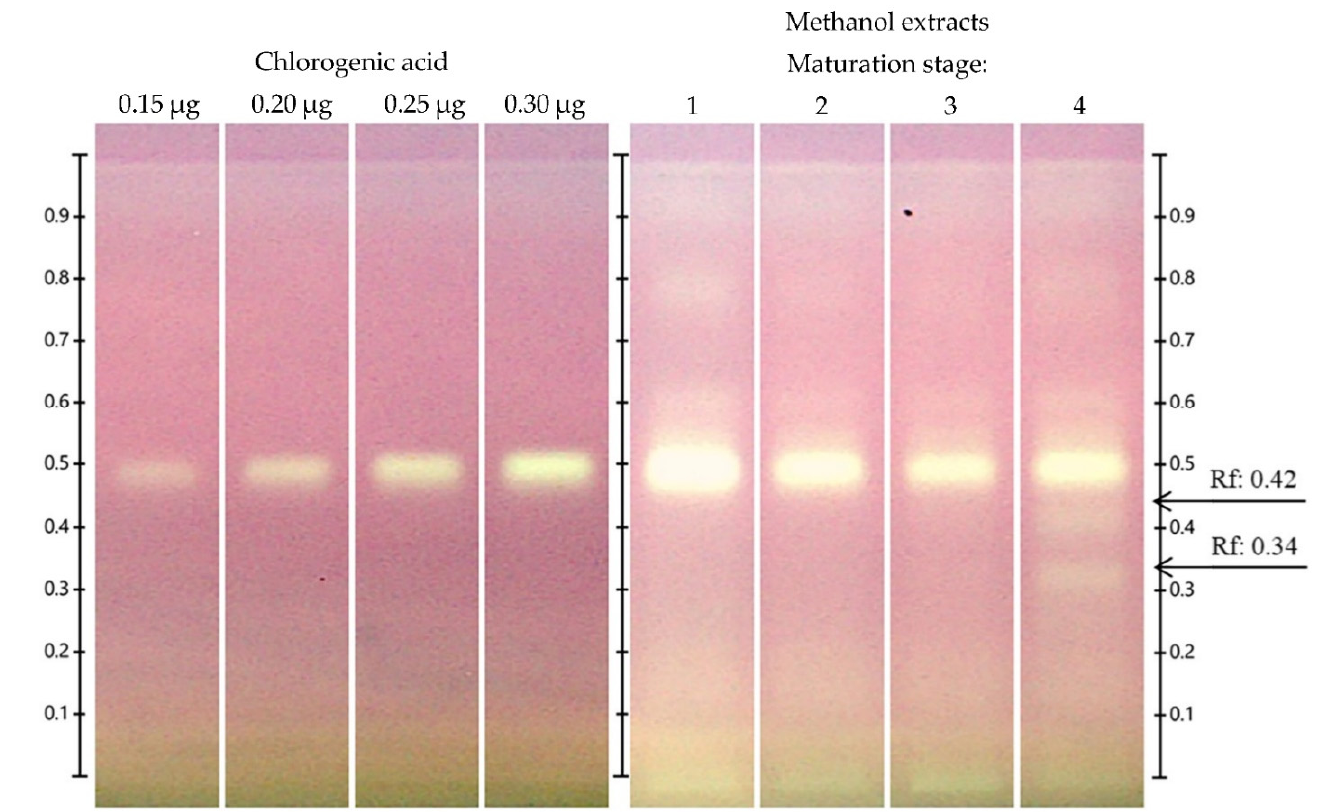
Figure 5. Detection of HPTLC-DPPH ● antioxidant compounds in extracts of Vaccinium stenophyllum Steud. fruits under white light illumination, after derivatization with NP reagent. Chlorogenic acid was applicated on different volumes as a 4-point calibrated (3, 6, 9 and 12 µL, equivalent to 0.3, 0.6, 0.9 and 1.2 µg; y = 2.745 × 10 − 4 x − 5.225 × 10 − 2 , R 2 = 0.9900). Vaccinium stenophyllum Steud. fruit extract (stages 1–4) were applied in triplicate, volume = 2 µL (20 mg DW/mL, w / v ). Bands from extract not identified with standard (R f : 0.42). Bands from extract identified as cyanidin-3-glucoside (R f :